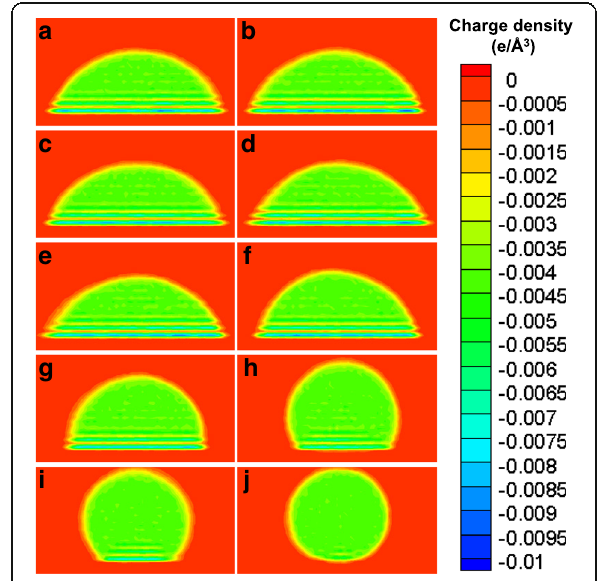
Fig. 6 Negative charge density distributions inside the cylindrical oil droplets in the x - z plane. a − 1.984 e/nm 2 . b − 0.992 e/nm 2 . c − 0.1984 e/nm 2 . d 0.0 e/nm 2 . e 0.1984 e/nm 2 . f 0.992 e/nm 2 . g 1.984 e/nm 2 . h 3.968 e/nm 2 . i 5.952 e/nm 2 . j 7.936 e/nm